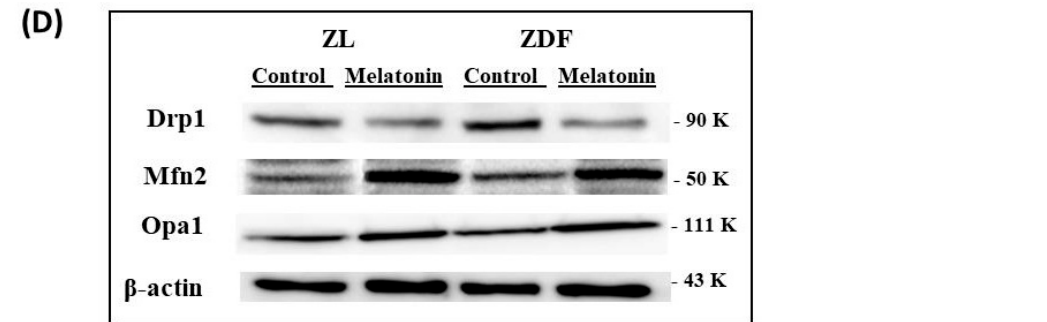
Figure 1. Effect of melatonin treatment on kidney mitochondria dynamic markers protein levels: ( A ) Drp1, Fission expression, and ( B ) Mfn2 and ( C ) Opa1, fusion levels in mitochondria isolated from